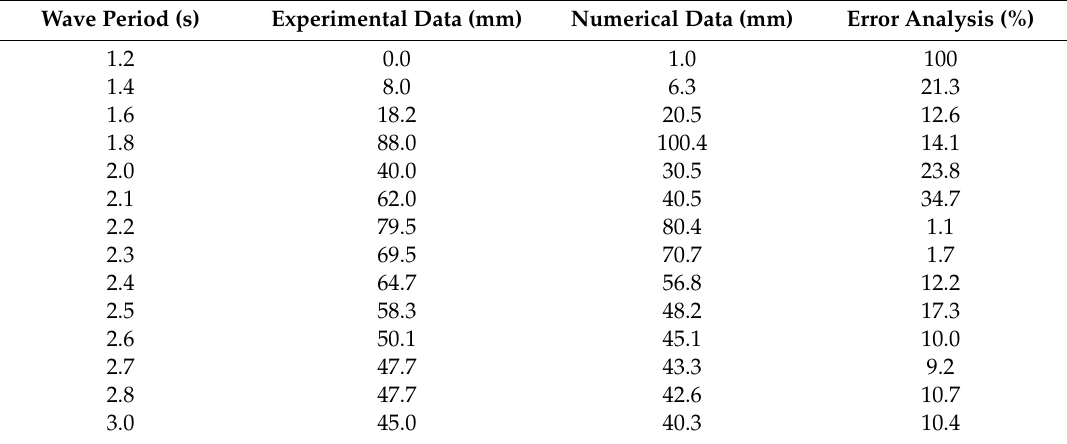
Table 6. Heave oscillation: error between the numerical and experimental